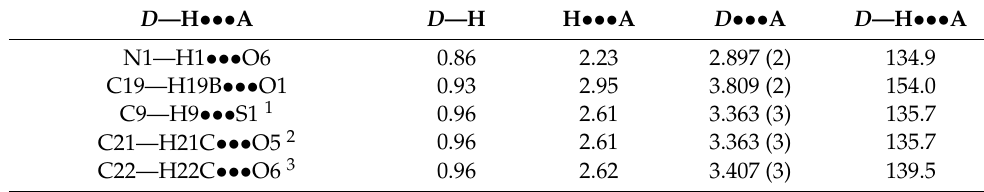
Table 2. Intramolecular and intermolecular contact parameters in the crystal structure of methyl 4-(4 (cid:48) -benzoyloxy-3 (cid:48) -methoxyphenyl)-1,2,3,4-tetrahydro-1,6-dimethyl-2-thioxopyrimidine-5- carboxylate ( 4j